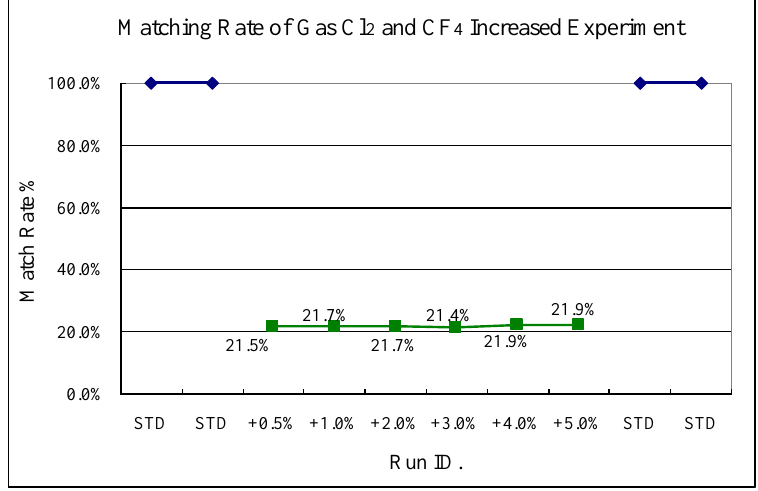
Figure 14. Experiment 5, Cl 2 and CF 4 variance at the same time. (Cl 2 from 50.25 to 52.25 sccm, STD = 50 sccm; CF 4 from 70.35 to 73.5 sccm; STD = 70